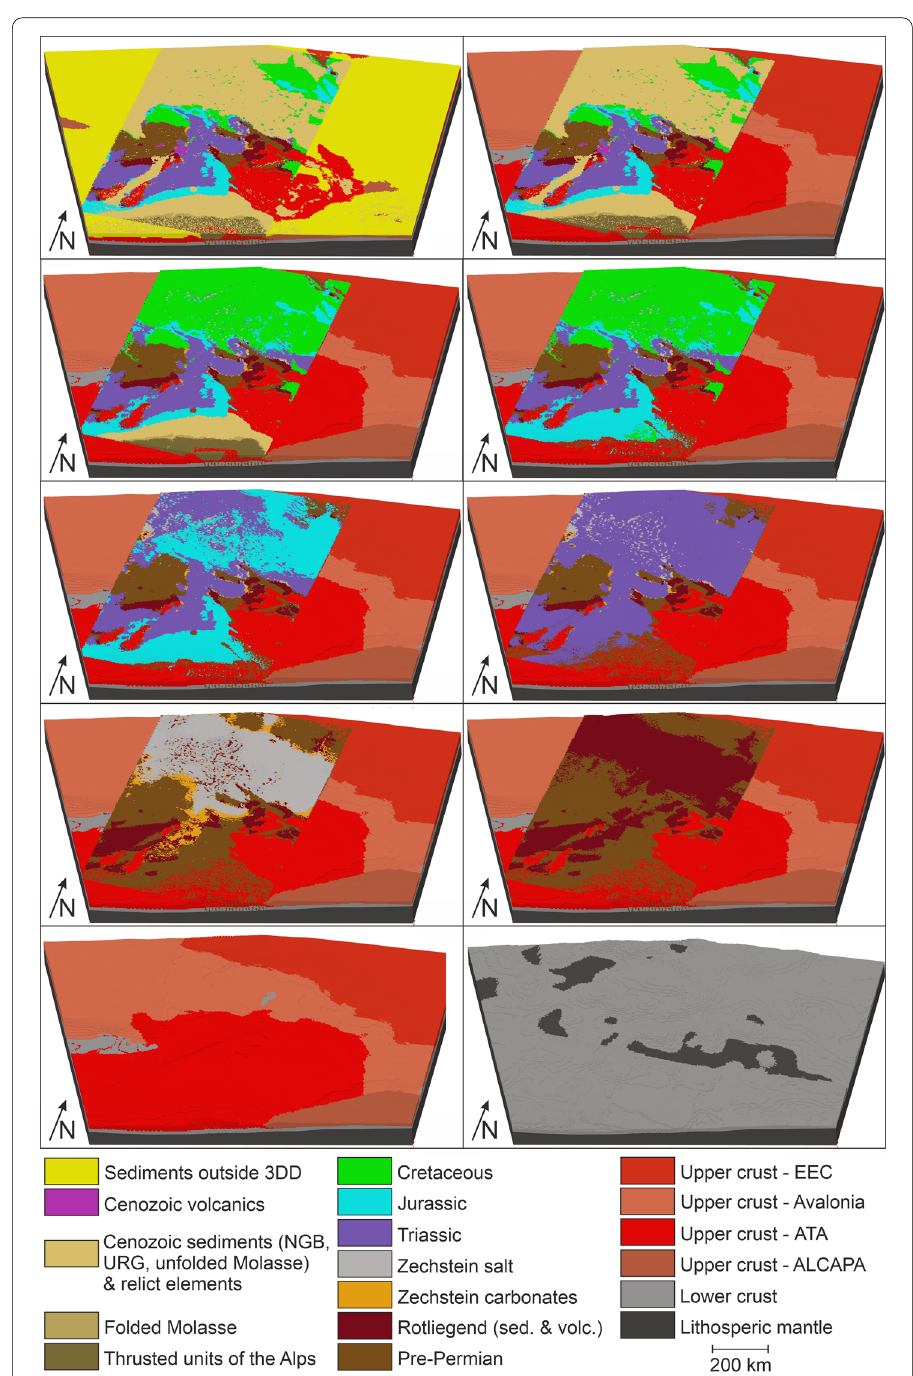
Fig. 2 Overview of the discretized model showing the internal structure including 22 units. ATA—Armorican Terrane Assemblage, ALCAPA—Alpine–Carpathian–Pannonian, EEC—East European Craton, NGB—North German Basin, URG—Upper Rhine